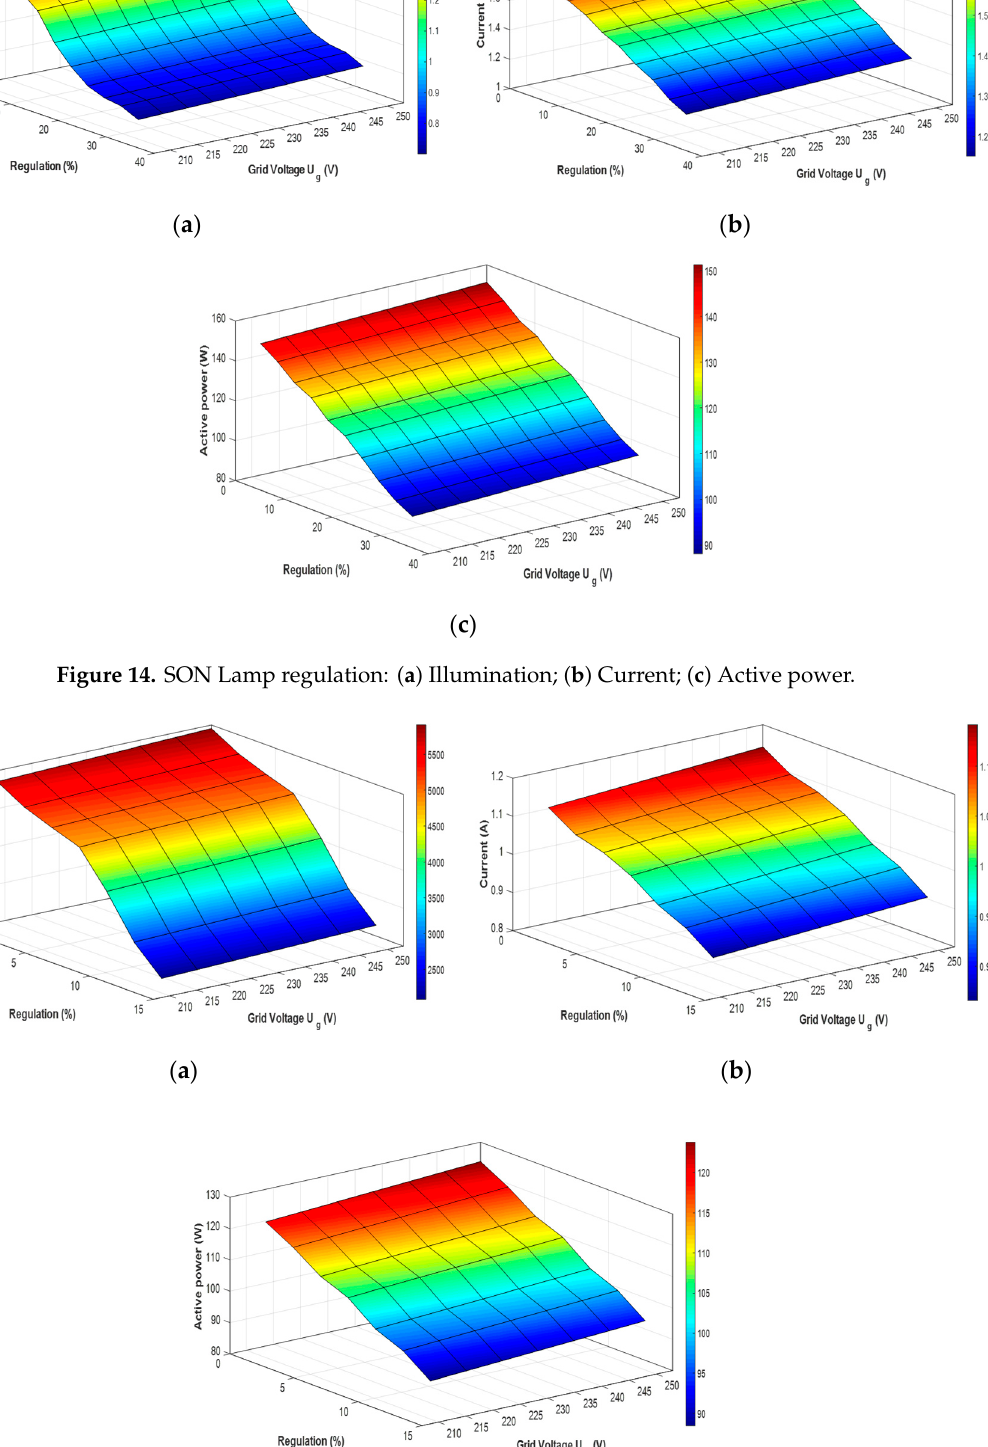
Figure 15. HPL Lamp regulation: ( a ) Illumination; ( b ) Current; ( c ) Active power.